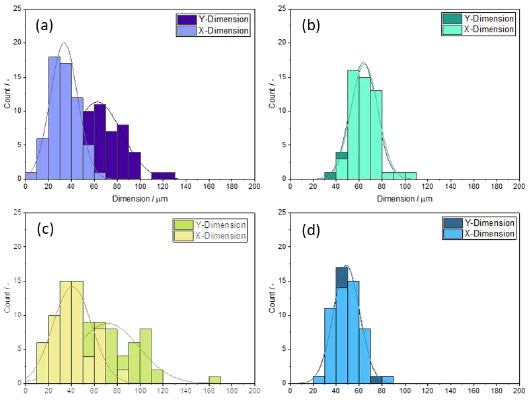
Figure A1. Particle size distribution of the used filler materials: ( a ) angular inert glass, ( b ) round inert glass, ( c ) angular bioactive glass, ( d ) round